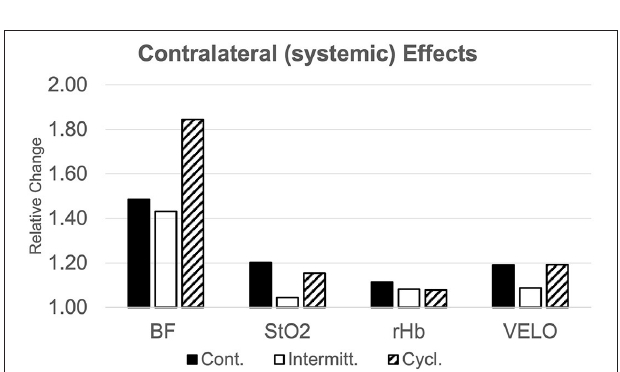
FIGURE 6 | Remote effect of NPWT. Relative changes of microcirculatory parameters compared to baseline values on the contralateral thigh 60-minutes after activation of the NPWT-device (BF, Bloodflow; StO 2 , Tissue Oxygen Saturation; rHb, relative Hemoglobin Content; VELO, Red Blood Cell Velocity).